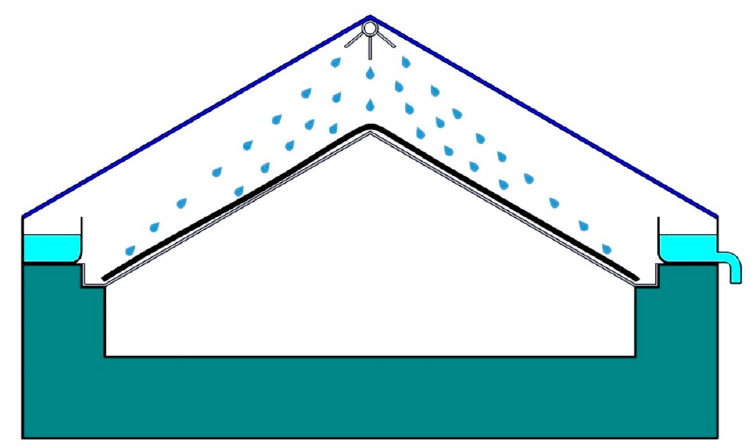
Figure 3. Geometric layout of the dual parallel spraying nozzles of seawater supply.